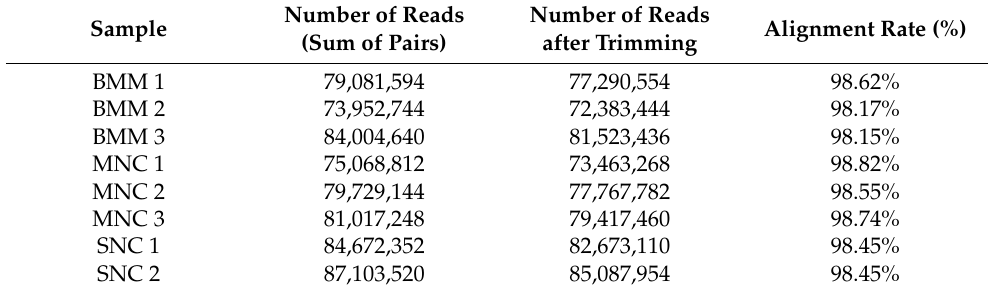
Figure 1. Transcriptomic profiling of single nucleated cells (SNCs) and multinucleated cells (MNCs) reveals distinct populations during osteoclastogenesis. ( A ) Schematic diagram of osteoclast differentiation and isolation of bone marrow-derived macrophages (BMMs), SNCs, and MNCs. ( B ) Principal component analysis (PCA) of BMMs, SNCs, and MNCs. Each dot represents the expression profile of one sample: n = 2–3. ( C ) The Venn diagram indicates differentially expressed genes (DEGs) for the three comparisons, specifically BMM-SNC, BMM-MNC, and SNC-MNC. ( D ) The DEGs for the three comparisons are displayed on the scatter plot. Blue and red indicate significantly dysregulated genes, and black indicates no significant differences (fragments per kilobase of exon per million fragments mapped (FPKM) > 1, q-value < 0.05). Table 1. RNA-seq analysis